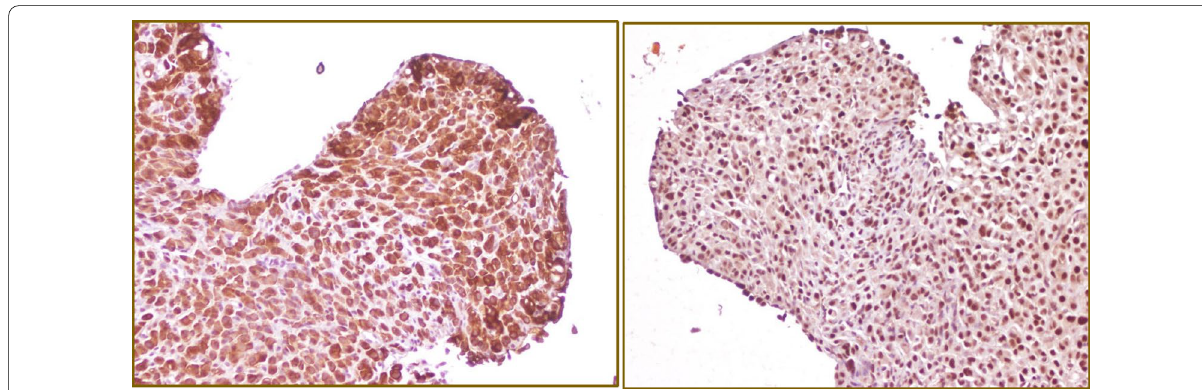
Fig. 2 Immunohistochemically, the tumor cells were positive for CK-7 ( a ) and GATA3 (b) (